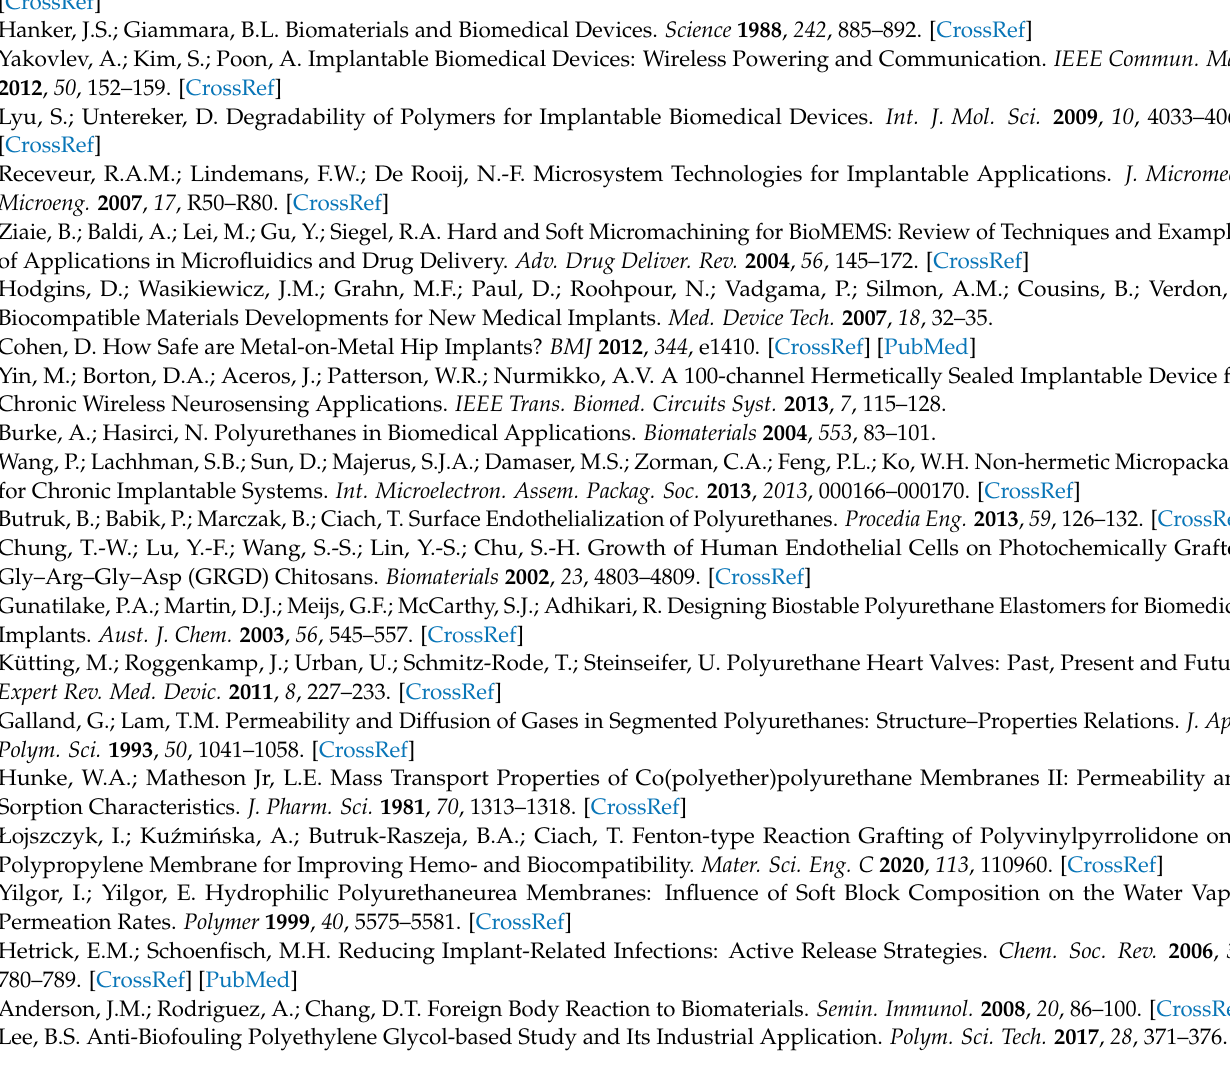
Figure S1: Tensile stress-strain value of HPEB90C10 with varying hexane treatment